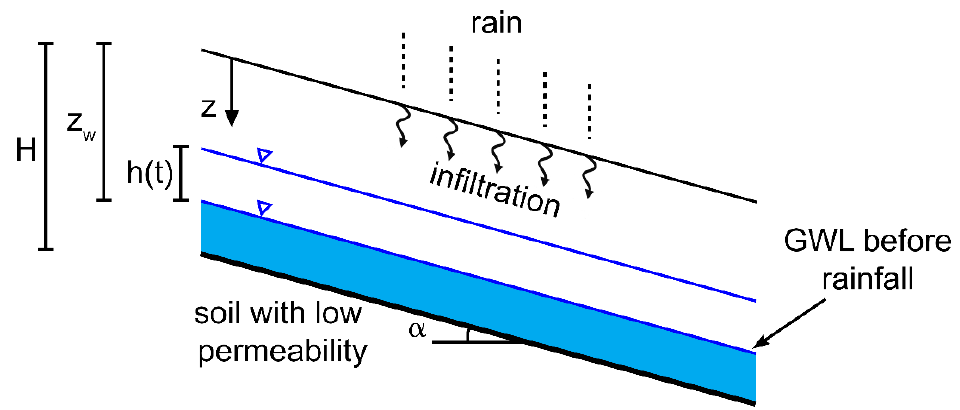
Figure 1. Scheme of infinite slope consisting of a cover layer on a less permeable soil, with h ( t ) indicating the change in the groundwater level (GWL) due to rain infiltration.